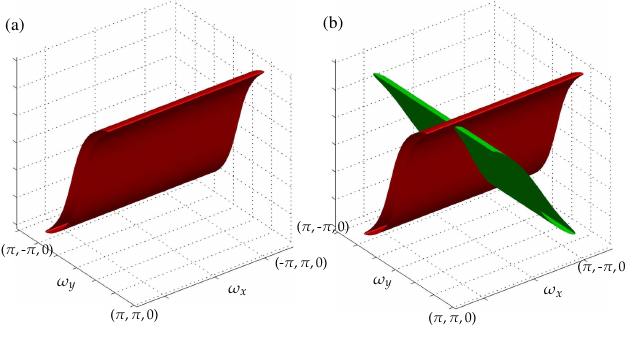
Figure 3. Frequency response of cascading of two 2D IIR beam filters to obtain the 3D IIR beam filter. ( a ) frequency response of H 1 ( x , ct ) and ( b ) responses of two filters before intersecting the beam